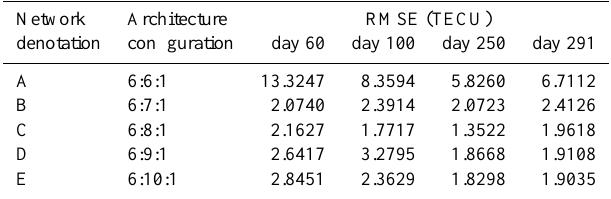
Table 1. RMSE (between predicted and measured GPS TEC) for some days in 2005 for different architectures when DN, HR, R4 and A8 are included in the ENN as